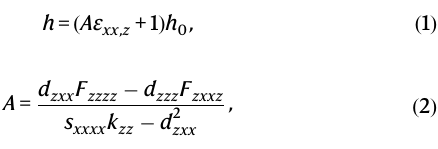
columns. The variation of lattice and oxygen octahedral from the internal (IS) to externalsurfaces(ES)canbeconjected asshownintherightschematics.Scalebar: 2nm. d – f Corresponding mapping results of in-plane and out-of-plane strain dis- tributions in bent regions marked by yellow trapezoids in ( a – c ),